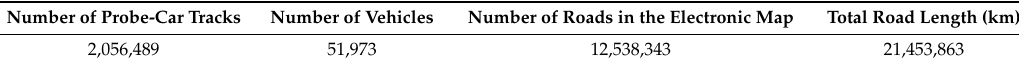
Table 2. Source data.